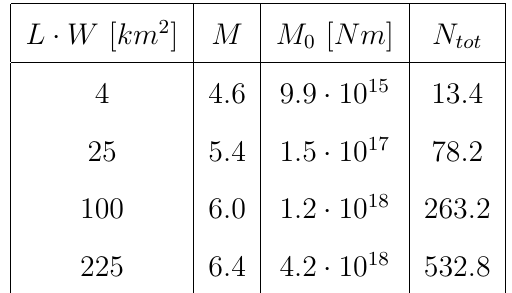
Table 4: Relation between fault parameters and aftershock production. The value of ∆ σ is fixed at 4 MP a ; the grid used in this computation has an area of 10 4 km 2 , the spacing on it is 0 . 5 km . The spacing on the fault is 0 . 05 km .